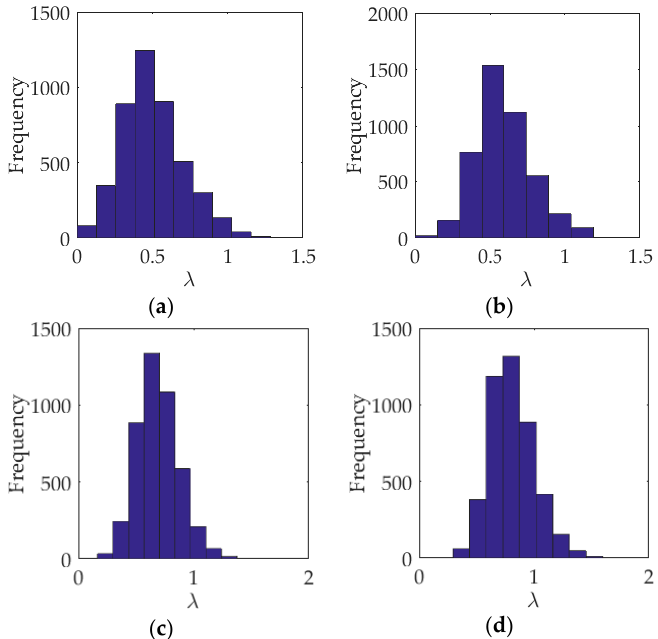
Figure 3. Frequency of the relative compression ratio of each particle under the different compression ratios: ( a ) η = 0.1; ( b ) η = 0.2; ( c ) η = 0.3; ( d ) η =